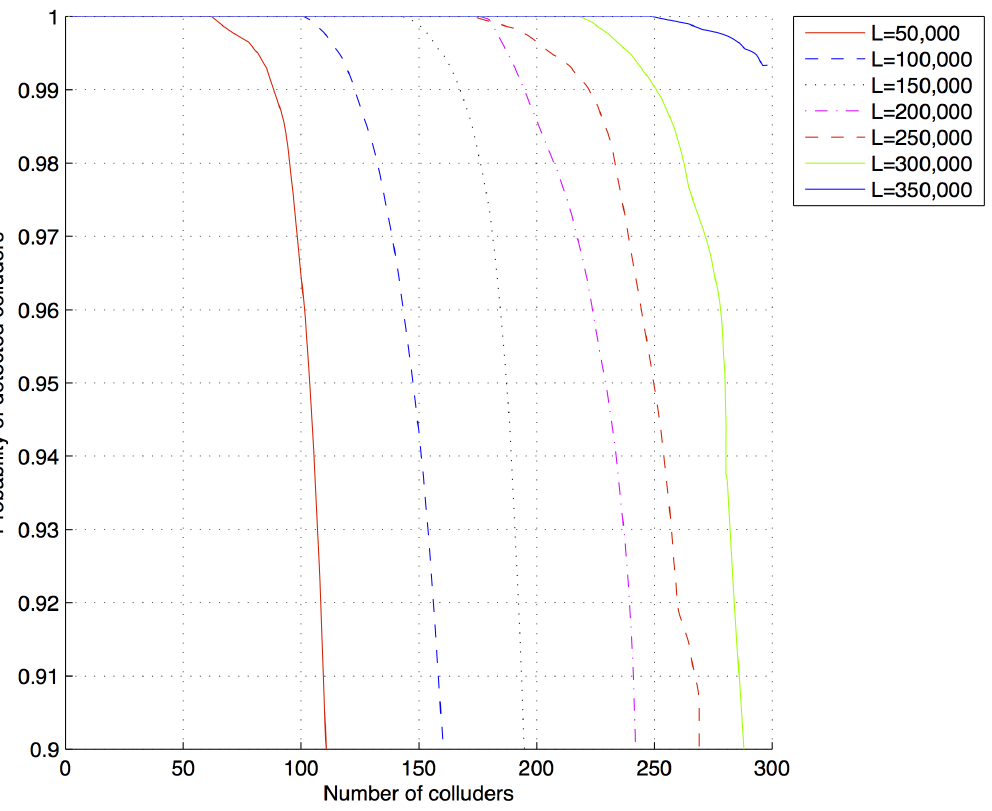
Figure 8. Probability of detected colluders after a collusion attack for fingerprints generated with B g ~ 50,000, B u ~ 200,000 and P w ~ 1 = 6 .